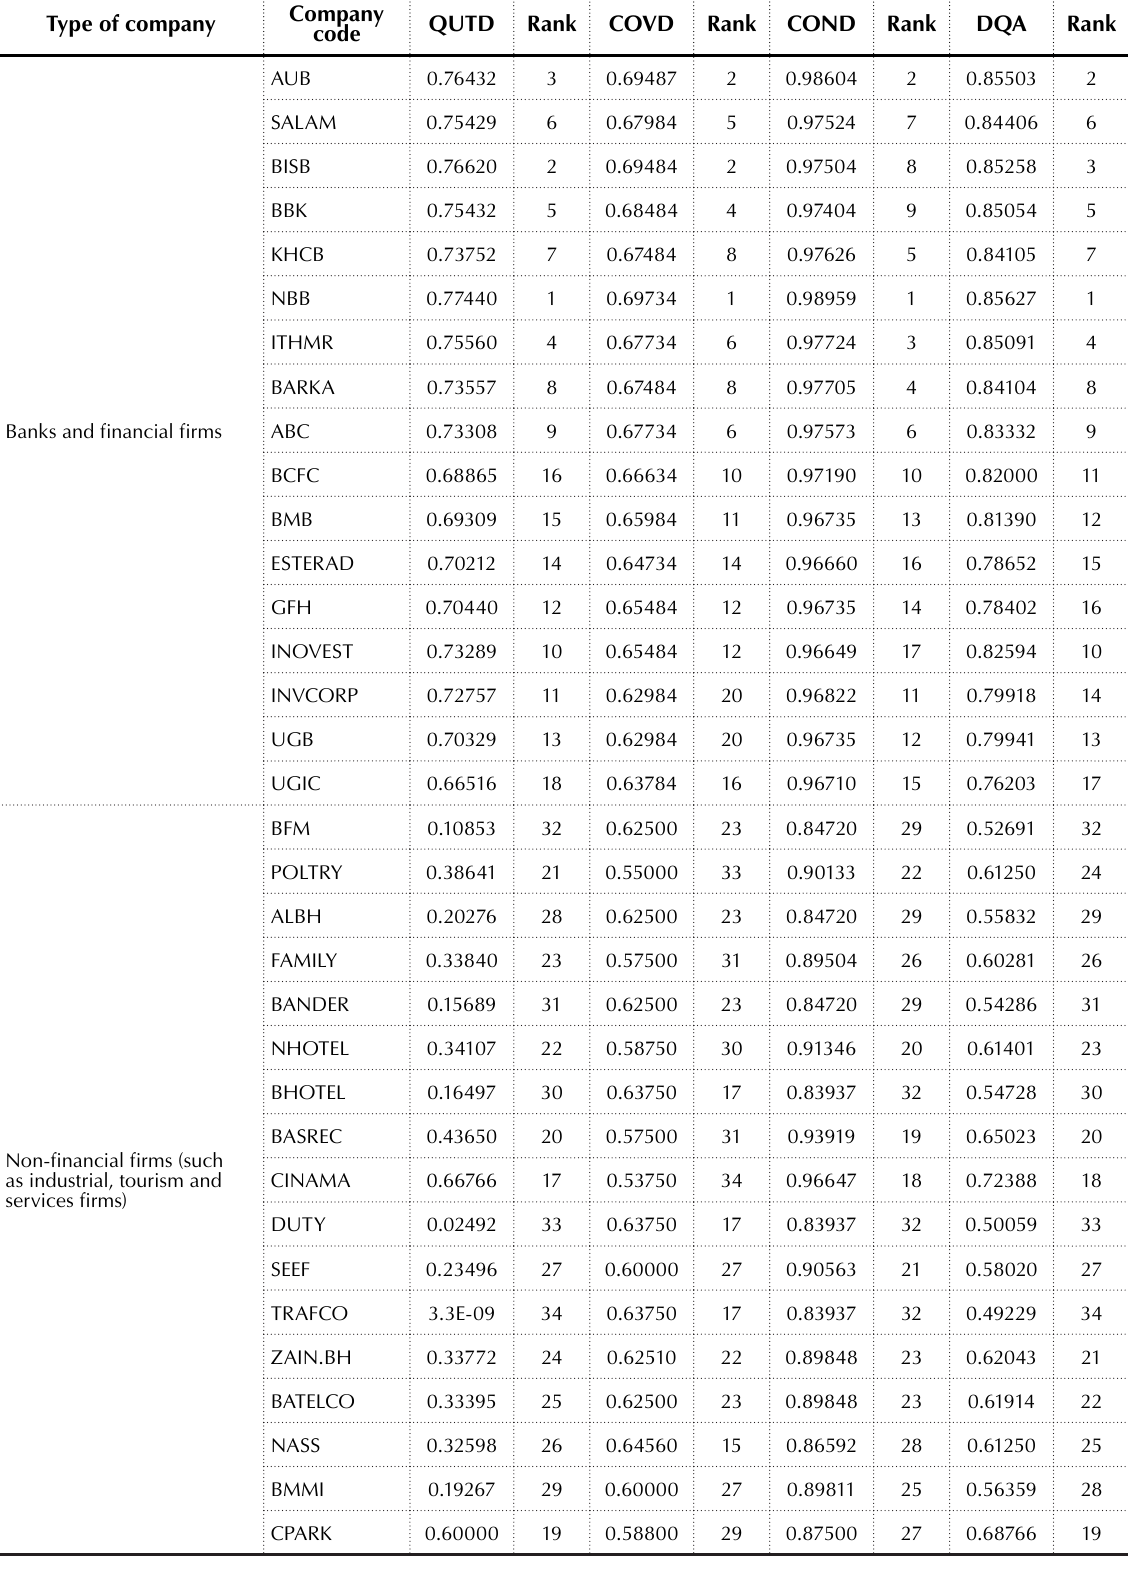
Table B2. Company ranking in year